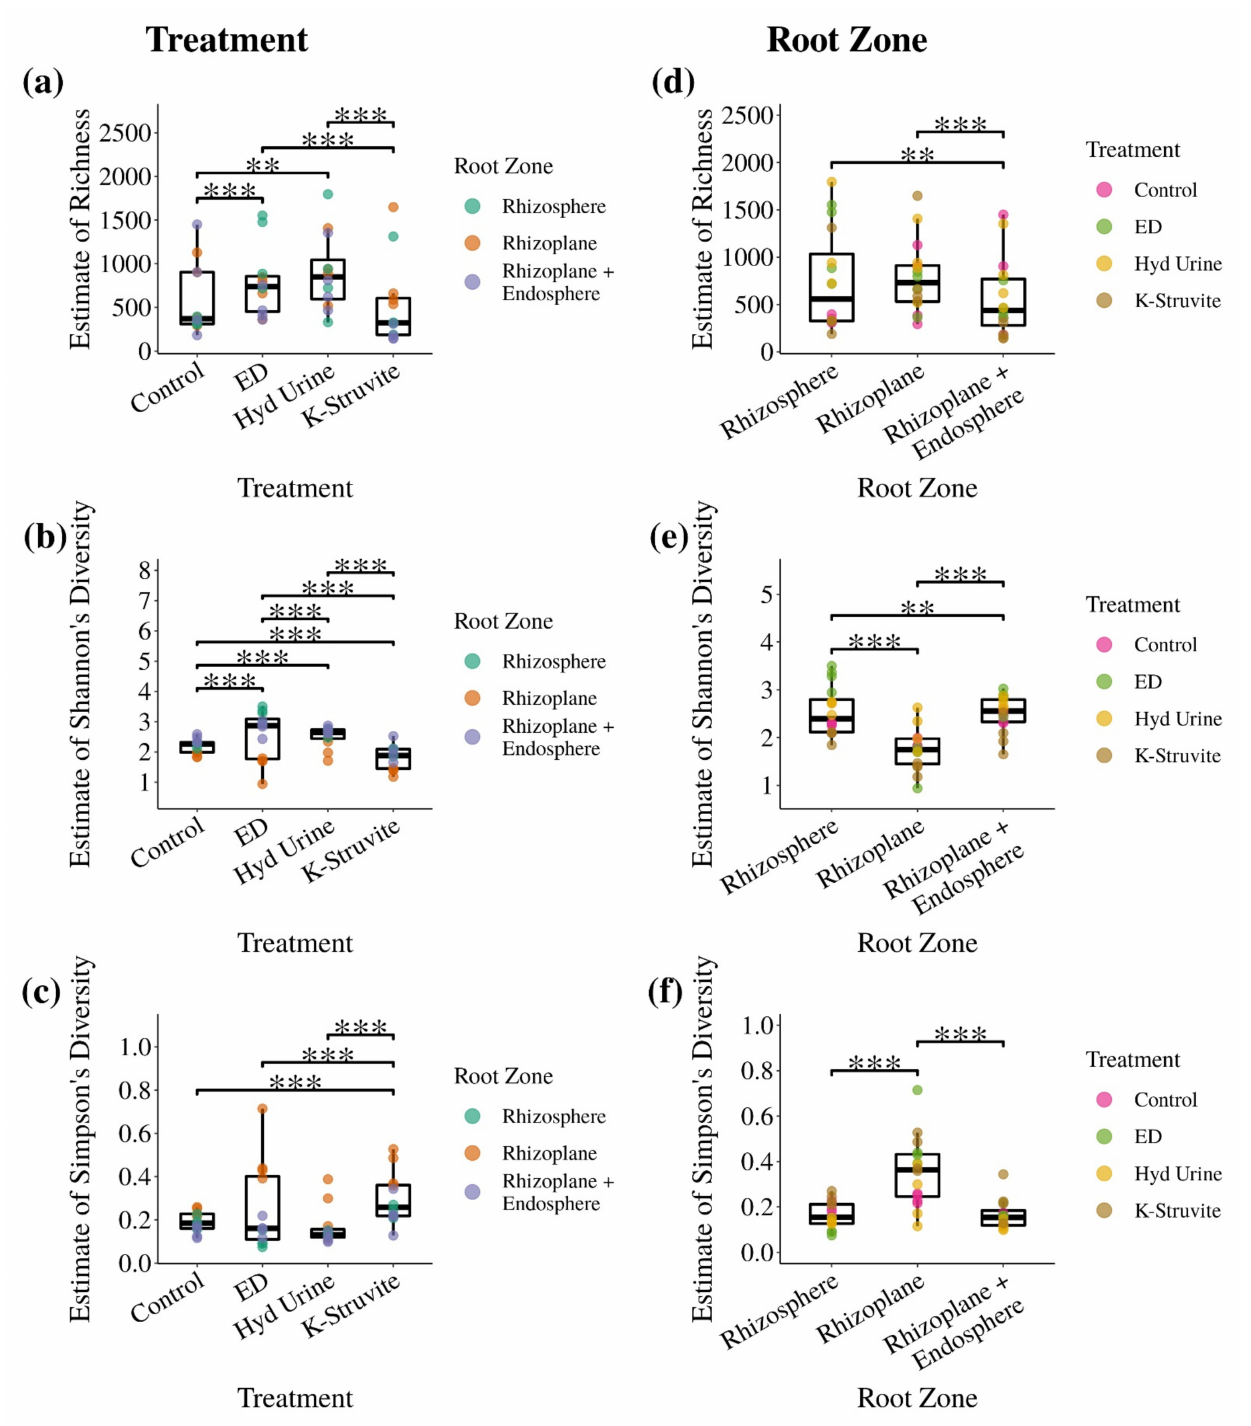
Figure 3. Boxplots of the richness, Shannon’s diversity, and Simpson’s alpha diversity indices of the lettuce root-associated bacterial communities grouped per urine-derived fertilizer treatment (ED: electrodialysis concentrate, Hyd Urine: hy- drolyzed urine) ( a – c ) or root zone ( d – f ). The alpha diversity indices were estimated by taking unknown taxa into account. Shannon’s diversity and Simpson’s diversity indices were determined at the genus level. Statistical comparison of the alpha diversity indices between urine-derived fertilizer treatments or root zones using the estimates’ variance in a mixed model approach. When fitting the model with urine-derived fertilizer treatment as a fixed effect, the root zone was added as a random effect and vice versa. Only significant pairwise comparisons are shown. Asterisks indicate level of significance: p < 0.01 (**) and p < 0.001 (***). N per urine-derived fertilizer treatment = 12 and n per root zone =